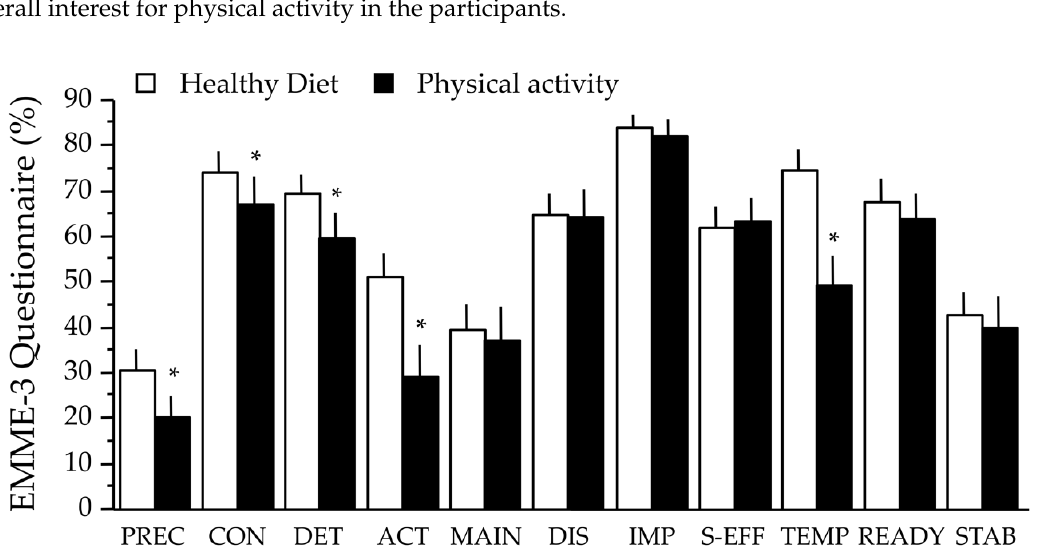
Figure 1. Scores of the EMME-3 questionnaire for healthy diet and physical activity at baseline. Data are expressed as mean ± SE. The asterisks indicate a significant difference between diet and physical activity ( p < 0.05, paired-t test). Abbreviations: PREC, precontemplation; CON, contemplation; DET, determination; ACT, action; MAIN, maintenance; DIS, discrepancy; IMP, importance; S-EFF, self- efficacy; TEMP, temptation; READY, readiness-to-change; STAB, stabilization-of-change.